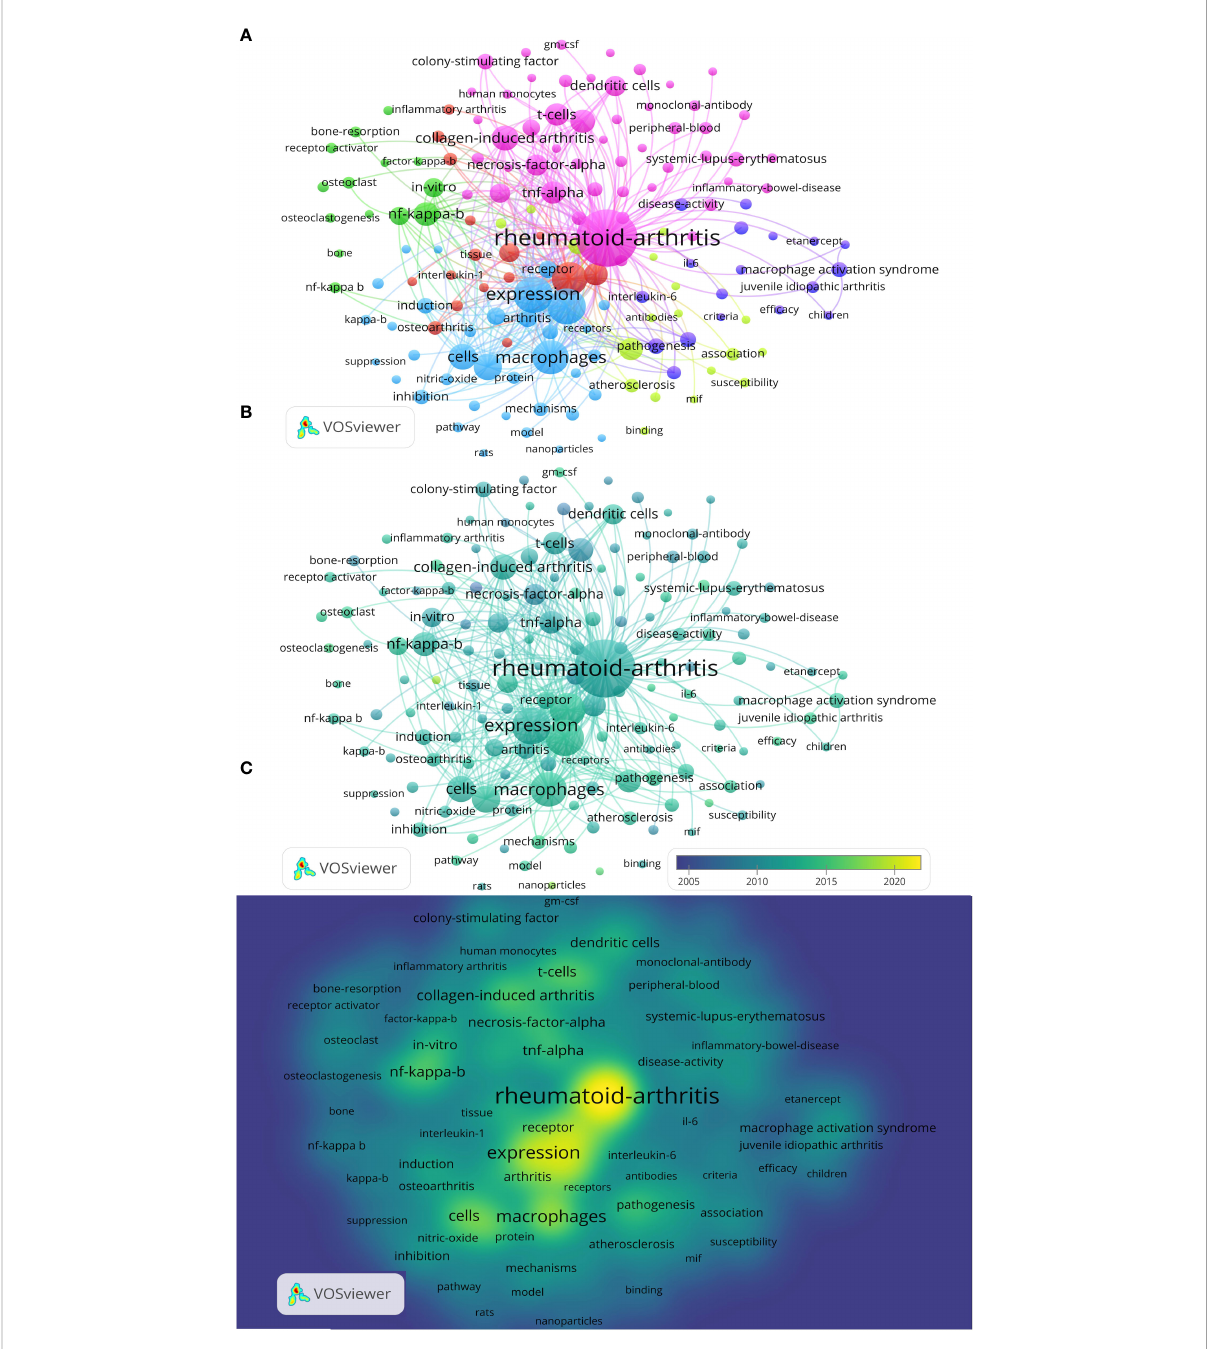
FIGURE 6 Cluster analysis of keywords from 2000-2021. (A) Cluster analysis of keywords. (B) Evolution of keywords. (C) Evolution of keywords